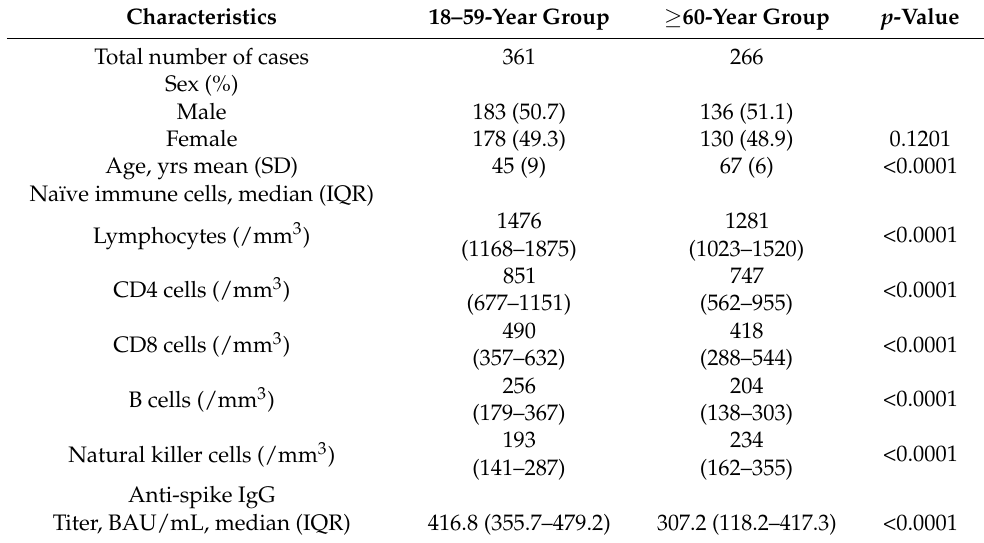
Table 1. Immunological characteristics of individuals before and after